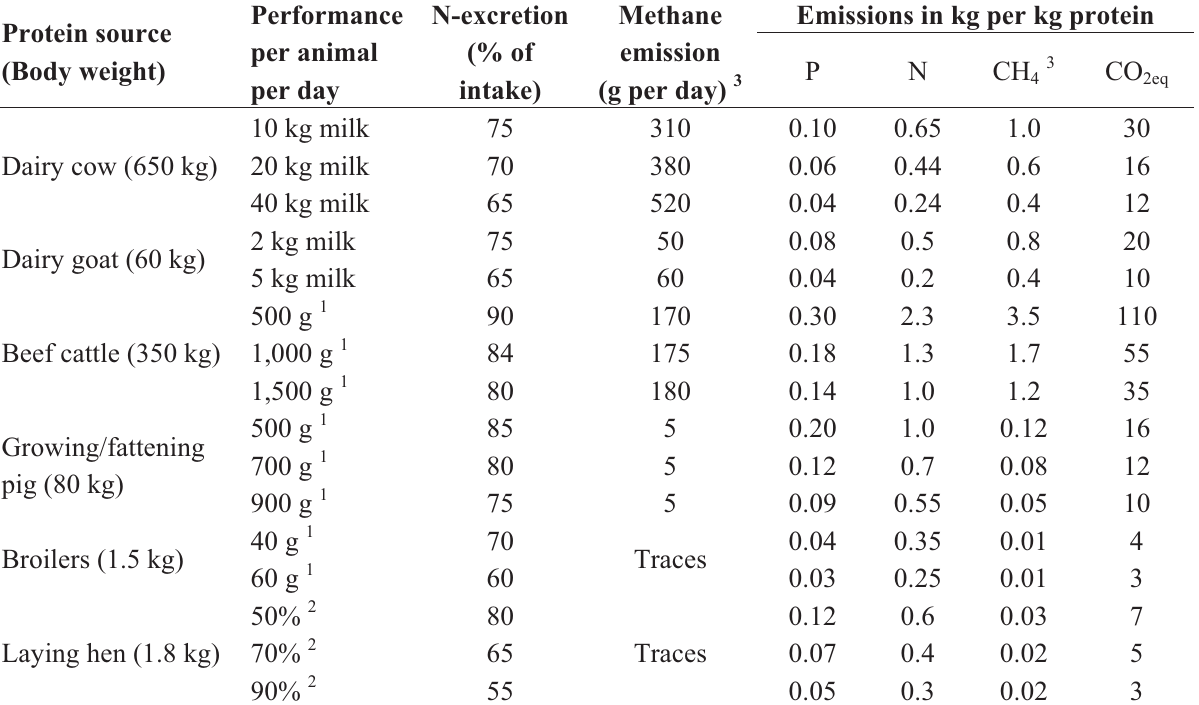
Table 8. Influence of animal species, categories and performances on emissions (per kg edible protein, own